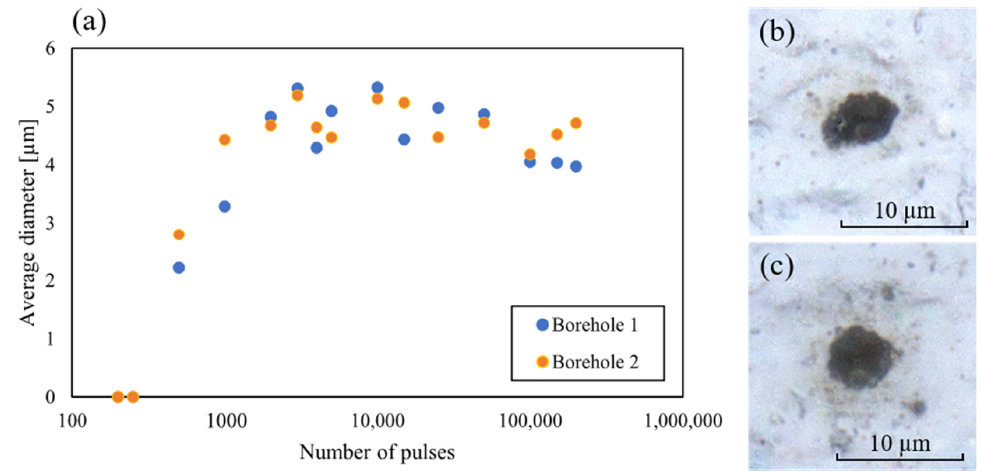
Figure 7. ( a ) Average diameter of the two holes drilled by a multi-Bessel beam as a function of the used number of pulses. The diameter is averaged through six drill holes, which were measured in x and y directions at an angle of 90 degrees. Please note, the standard deviation, of the measured quantities is in the order of 0.7 µm and is thus not considered in the diagram. ( b ) Outlet of a with 1000-pulse-drilled holes. ( c ) Outlet of with 10.000-pulse-drilled holes.